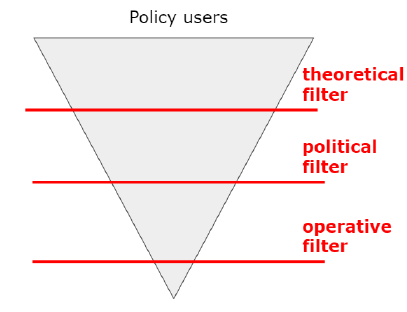
Fig. 2. Policy Validation